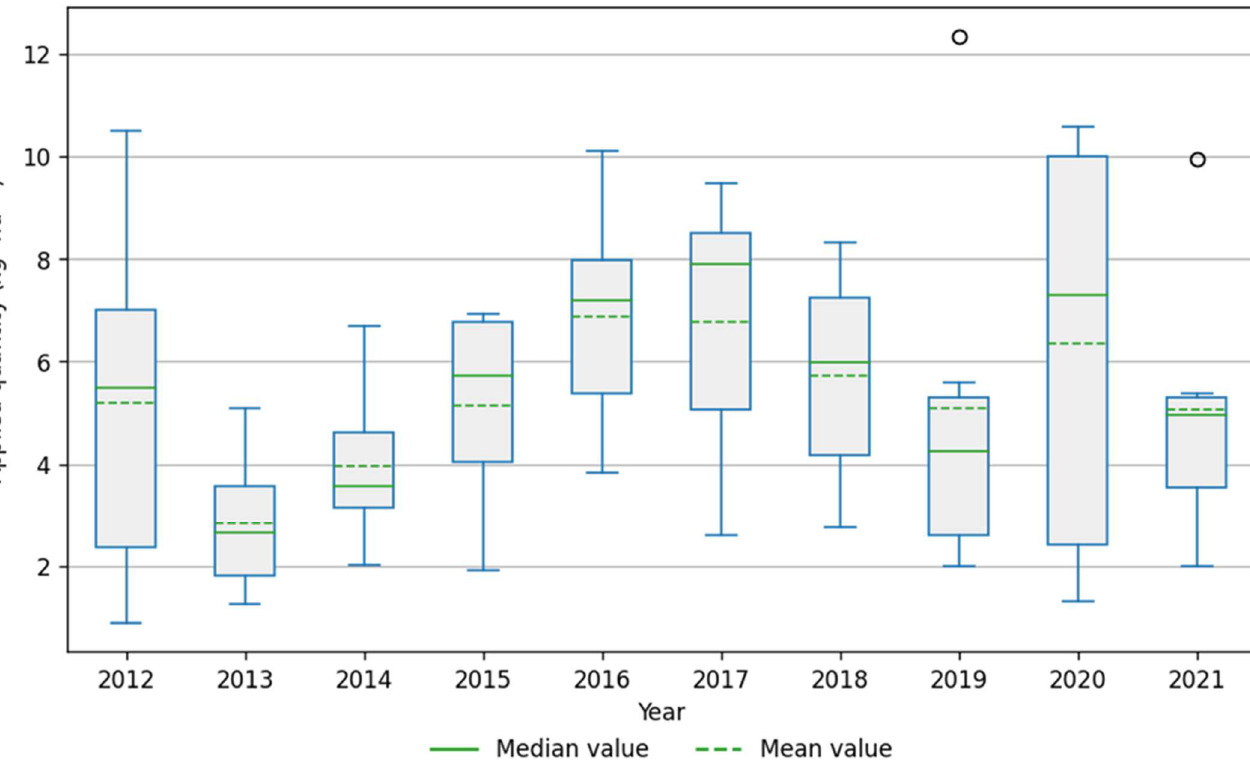
Figure 5. Distribution of data on the use of active substances in the selected six farms during the 2012–2021 apple-growing seasons.